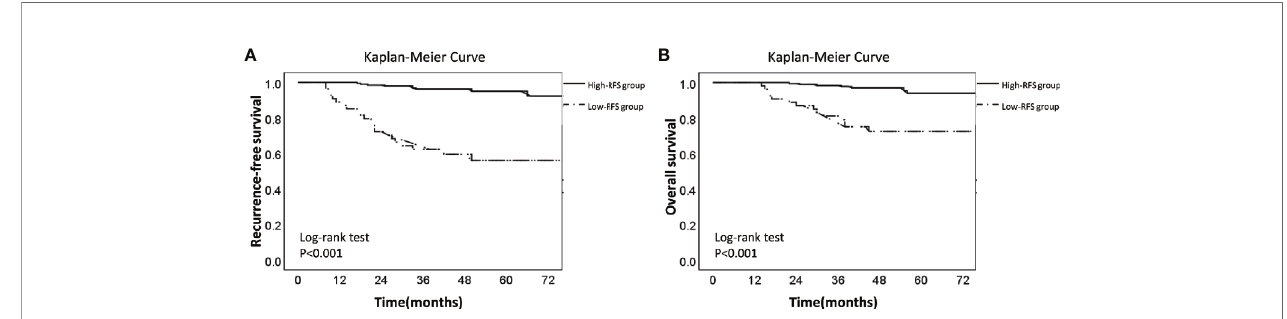
FIGURE 5 | Kaplan-Meier Survival Curve of low-RFS group and high-RFS group. Description: (A) Recurrence-free survival curve of low-RFS group and high-RFS group. (B) Overall survival curve of low-RFS group and high-RFS group (The dotted line: low-RFS group; The solid line: high-RFS group).